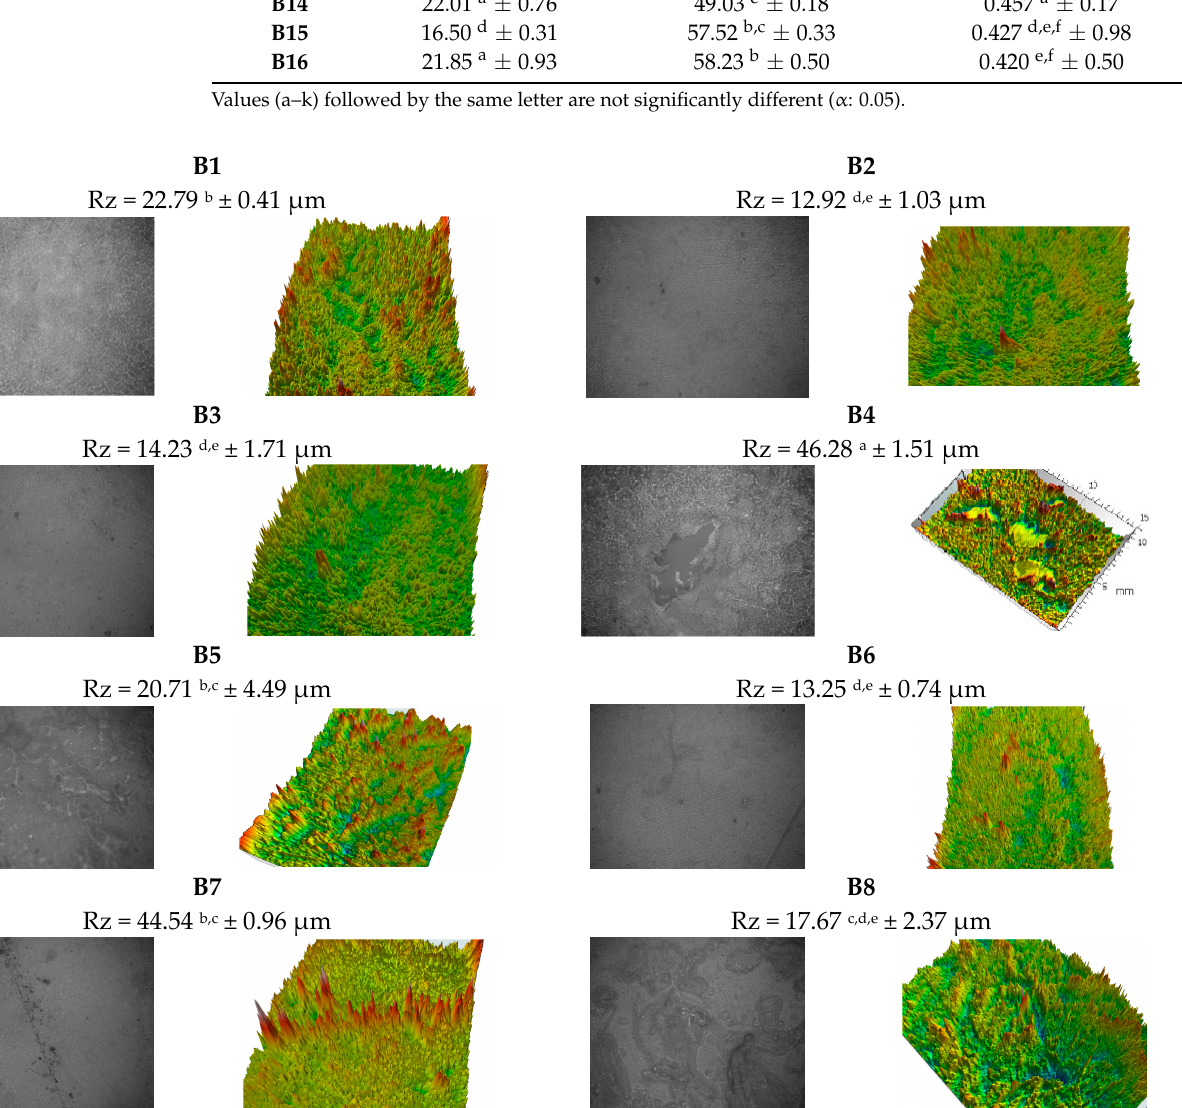
Table 3. Physical evaluation.